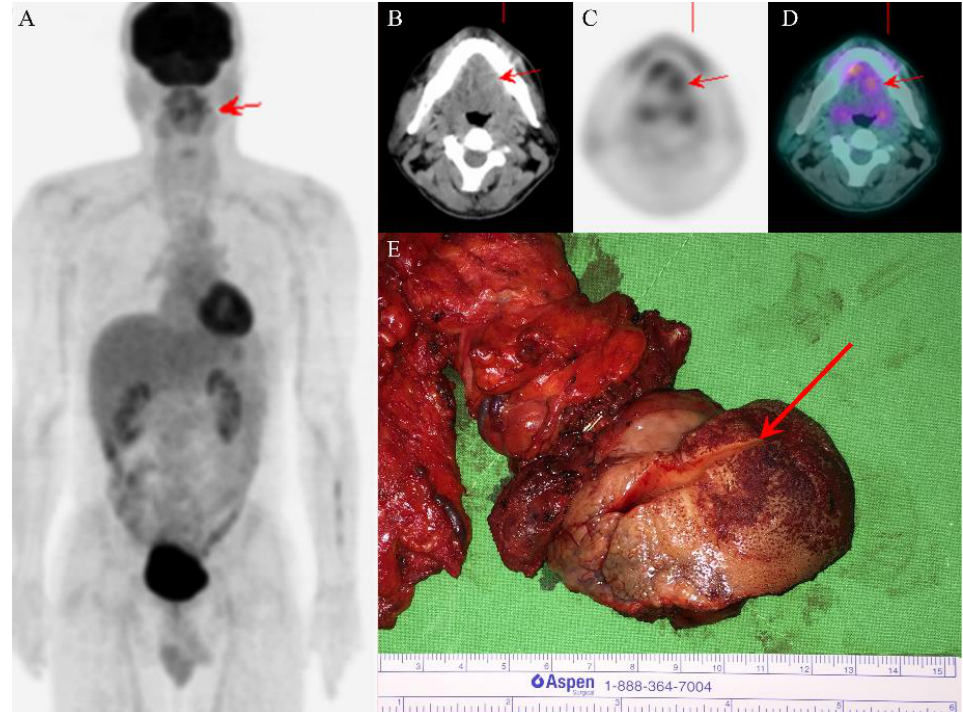
Figure 1. PET/CT images revealed one ill-defined infiltrative tumor (red arrows) over the left tongue with high uptake of fluorodeoxyglucose and absence of regional lymph node involvement or distant metastasis ( A – D ). The wide excision of the left tongue tumor grossly showed ulcerative mucosa and one ill-defined white submucosal tumor after cutting (red arrow) ( E ).